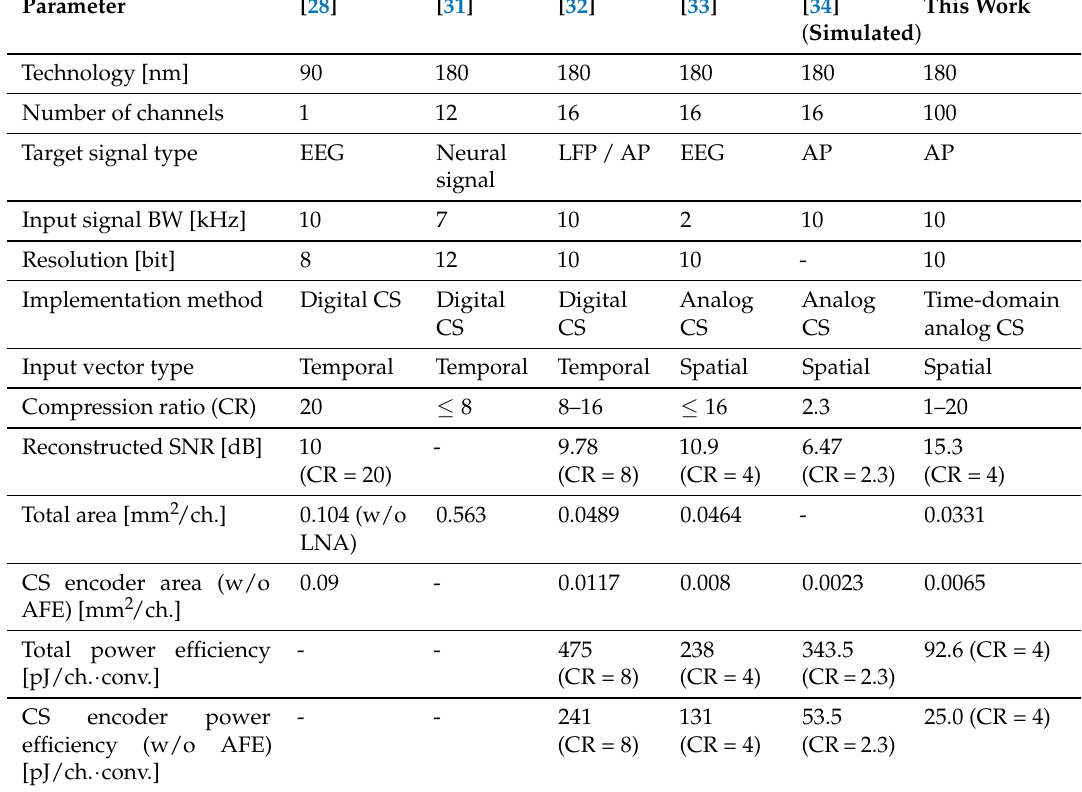
Table 1. Performance comparison to previous